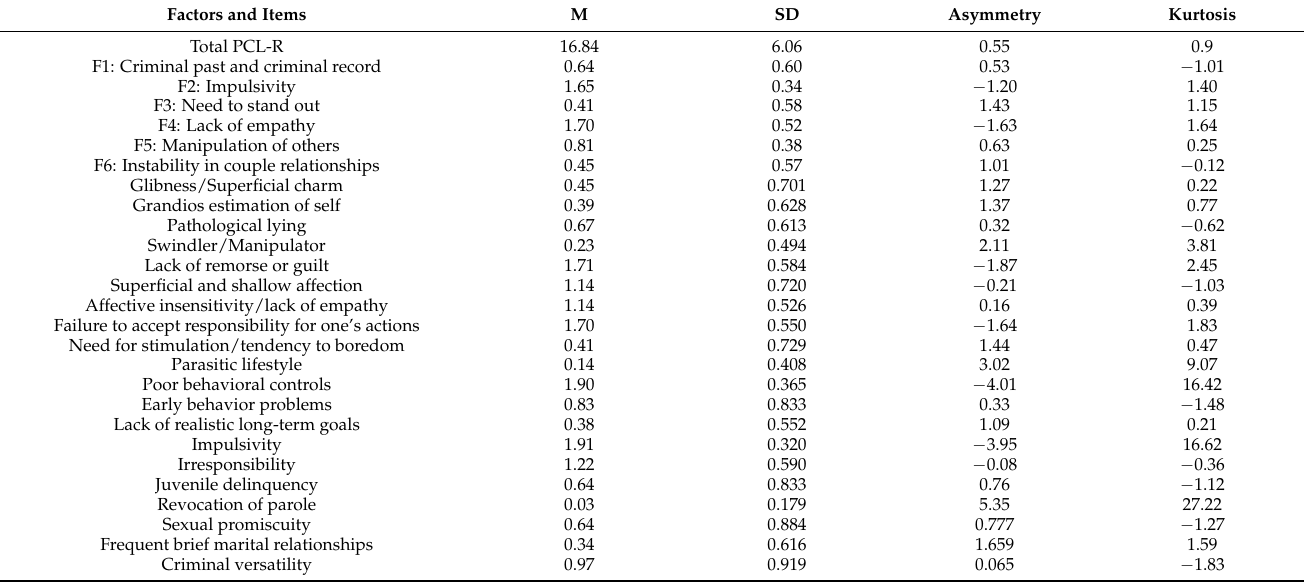
Table 2. Descriptive statistics of the target variables.